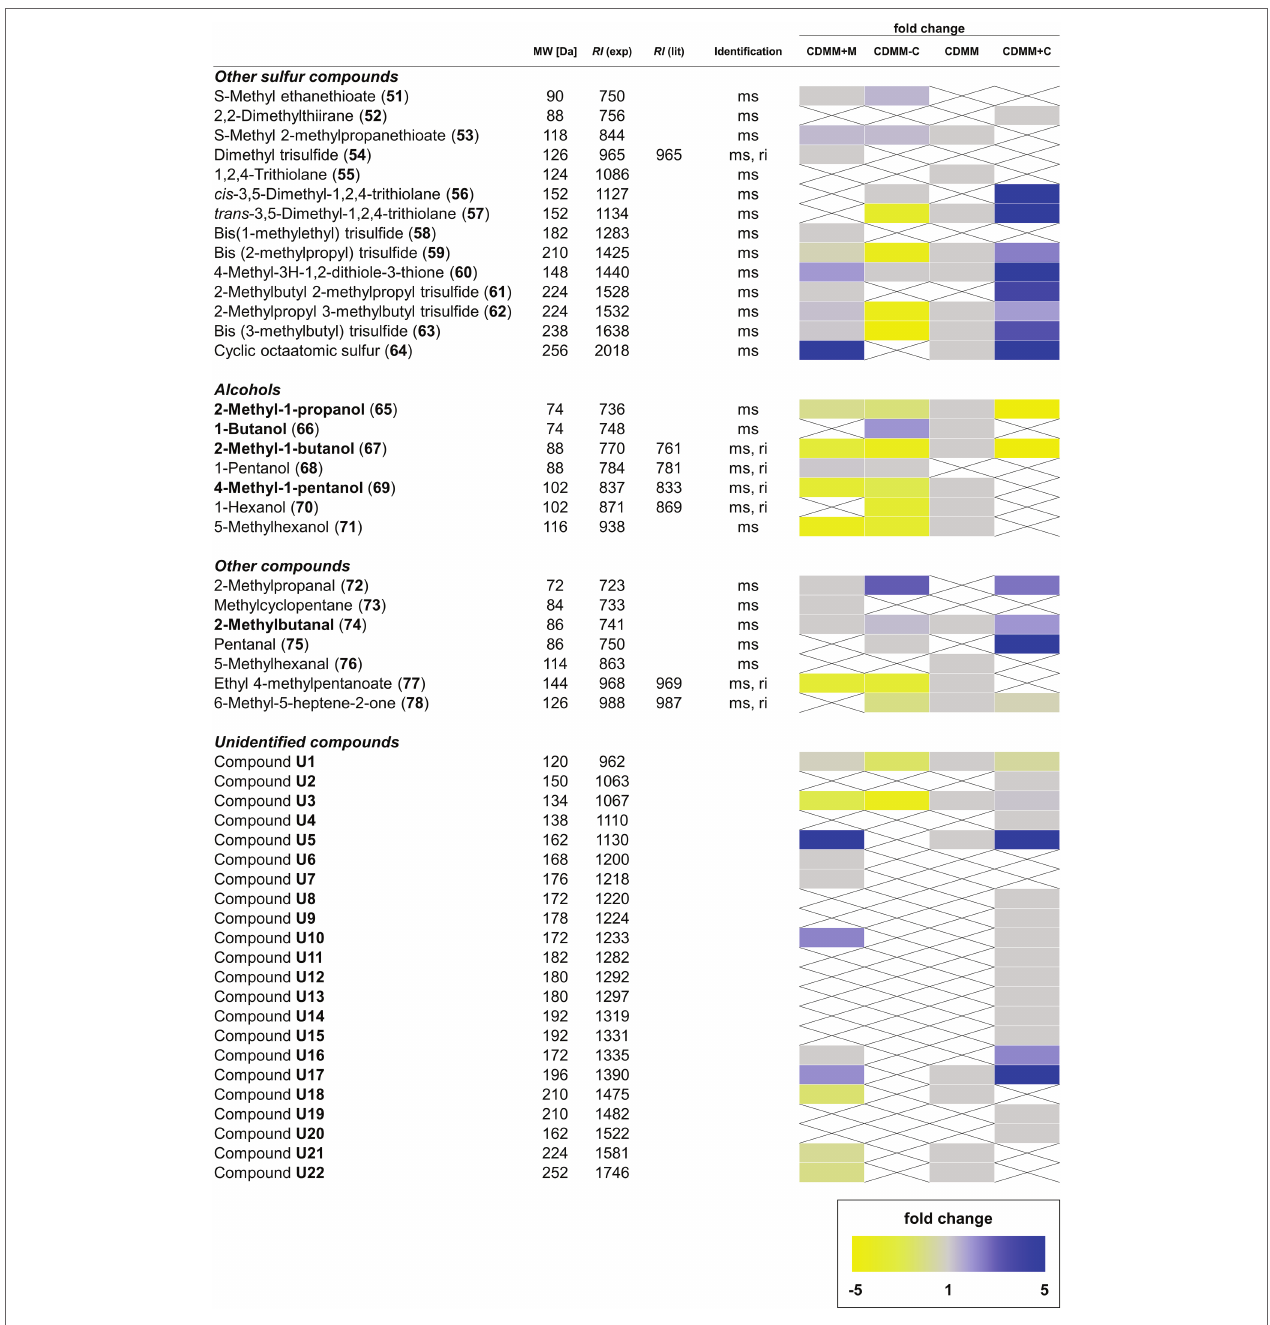
FIGURE 4 | Overview of other sulfur-containing and non-sulfur-containing volatile organic compounds (VOCs), as well as alcohols and unidentified compounds found in Clostridioides difficile 630 Δ erm . For details see Figure 3